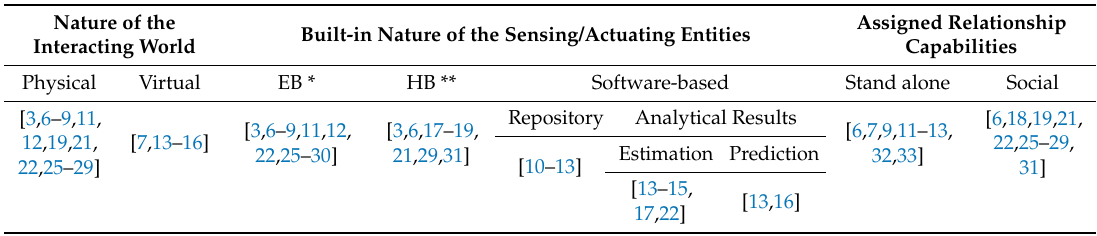
Table 3. Identification of relevant work, organised according to the proposed taxonomy.